Question: Generate an informative caption for the figure above.
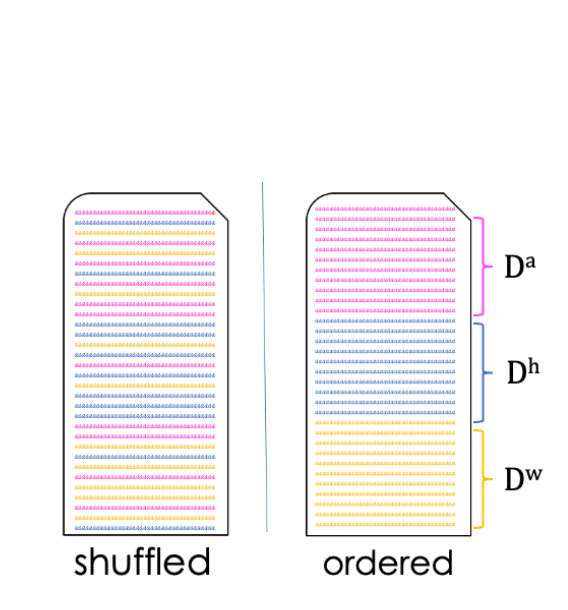
Answer: Illustration showing shuffled vs. ordered input for multi-document summarization consisting of documents from three diverse groups (Da, Dh, Dw) as indicated by the three colors. The ordered input is denoted as Oa when Da documents appear first in the input.